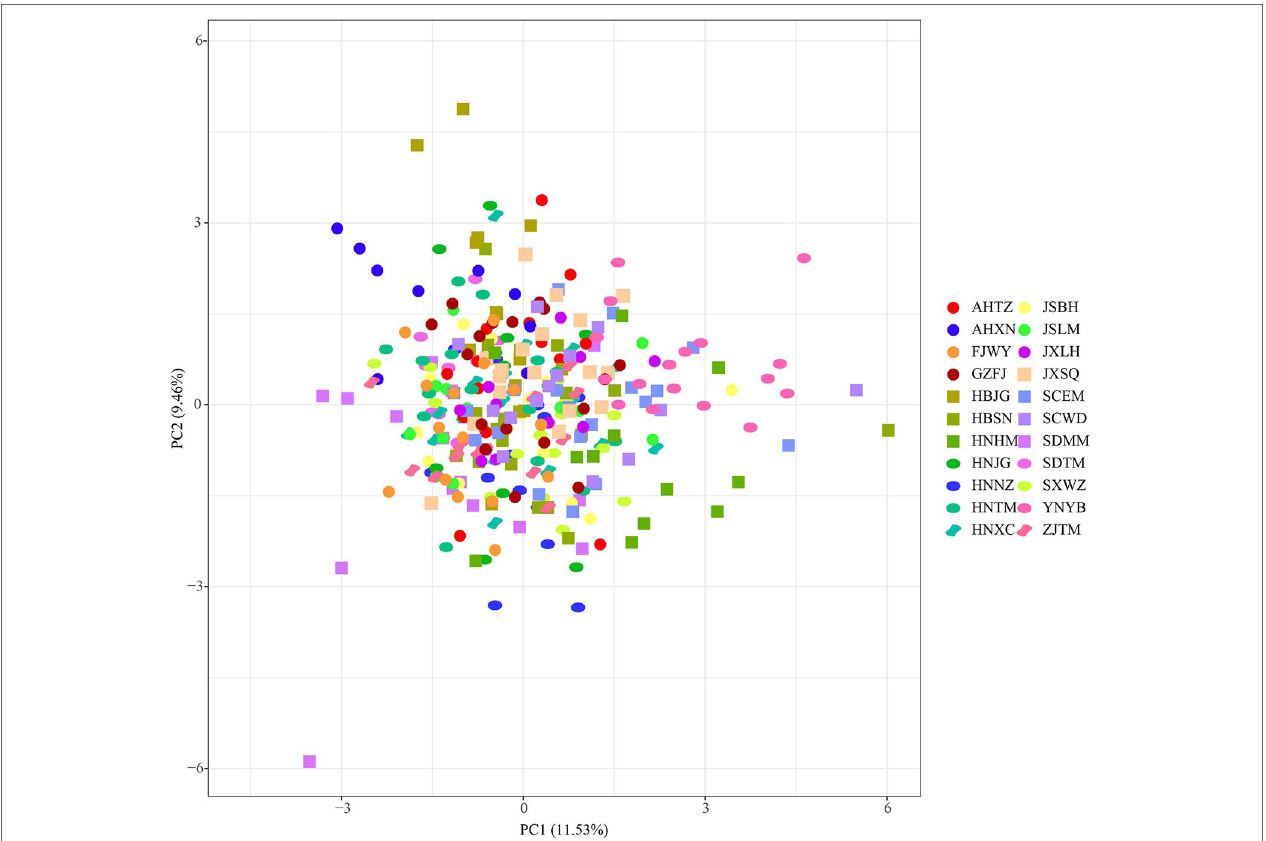
FIGURe 4 | Principal component analysis based on simple sequence repeat (SSR) data. Population codes were showed in Table 1 .